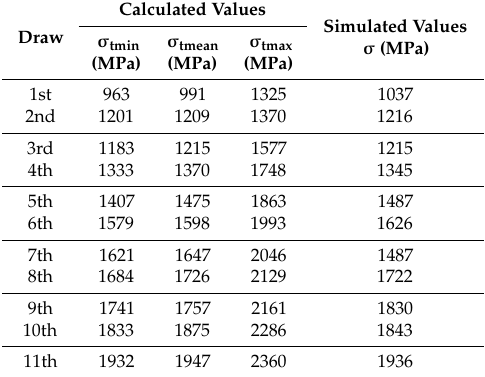
Table 7. Comparison table of measured and simulated values of tube wall thickness after individual drawings. Measured Draw